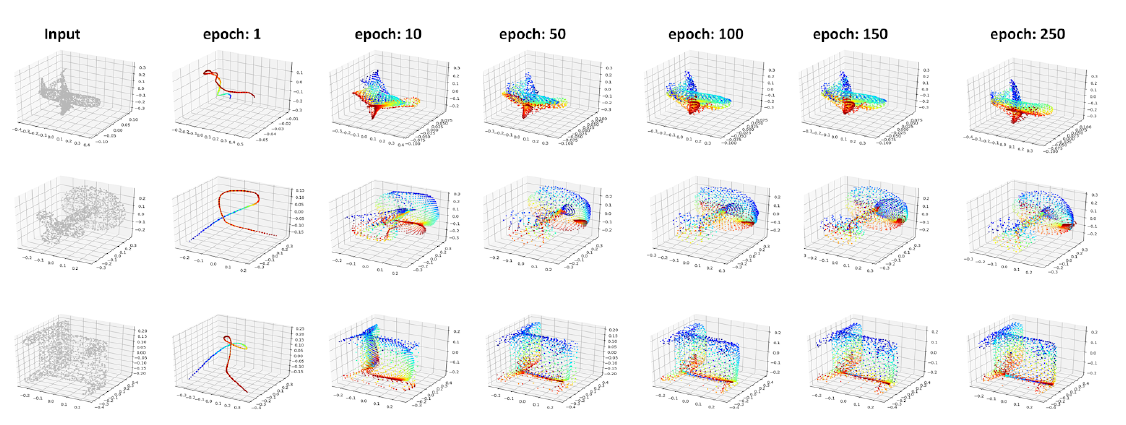
Figure 3. Illustration of the training process to show how different codewords gradually transfer into a meaningful point cloud. The left most column contains the different input features; the other columns show the reconstructed corresponding point clouds in different epochs.